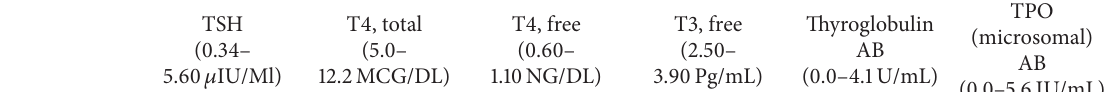
Table 1: Profile of thyroid function tests and timeline of patient’s wife postpartum